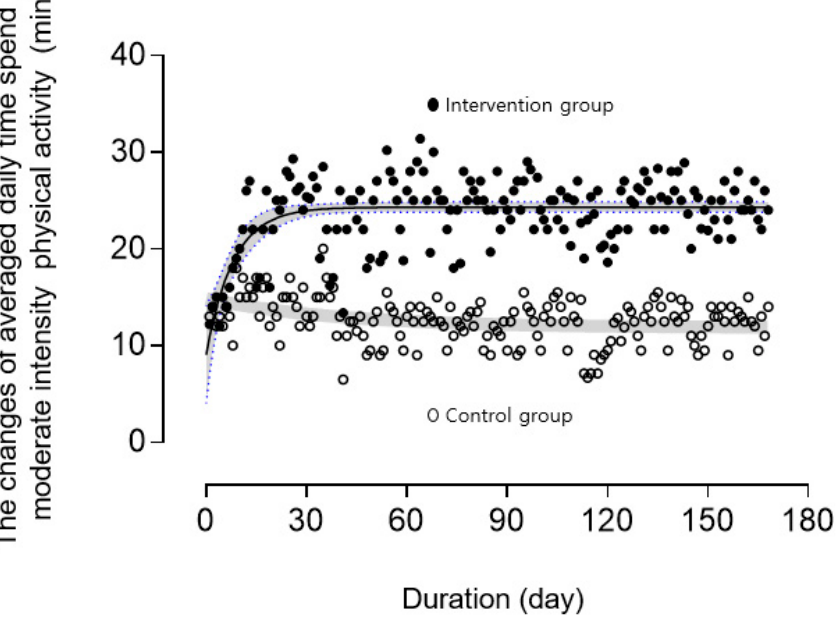
Figure 3. Changes in averaged daily moderate to vigorous physical activity during the intervention period. Black and gray lines show curve-fitting in both linear and exponential fit and 95% confidence band. Both groups wore waist-mounted accelerometers during the intervention period.